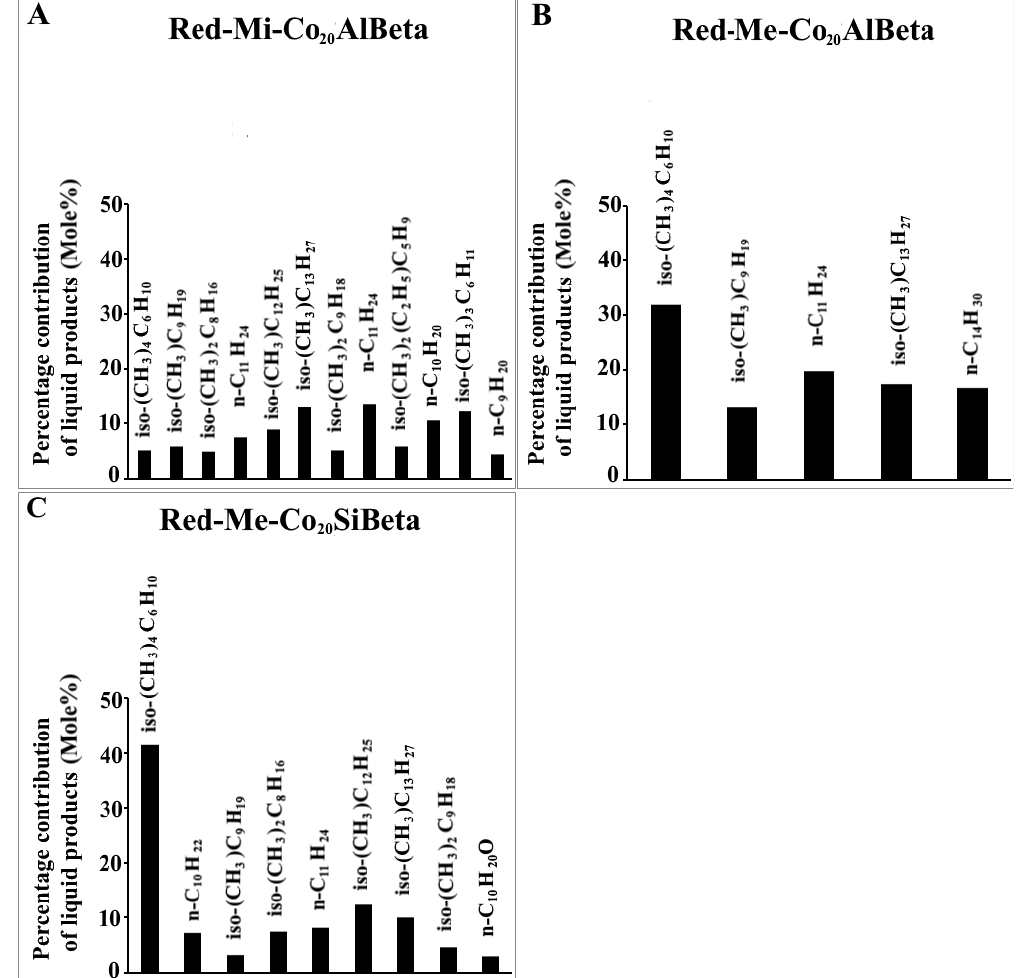
Figure 14. Distribution of compounds in liquid products obtained in FTS over ( A ) Red-Mi-Co 20 AlBeta, ( B ) Red-Me-Co 20 AlBeta and ( C ) Red-Me-Co 20 SiBeta.